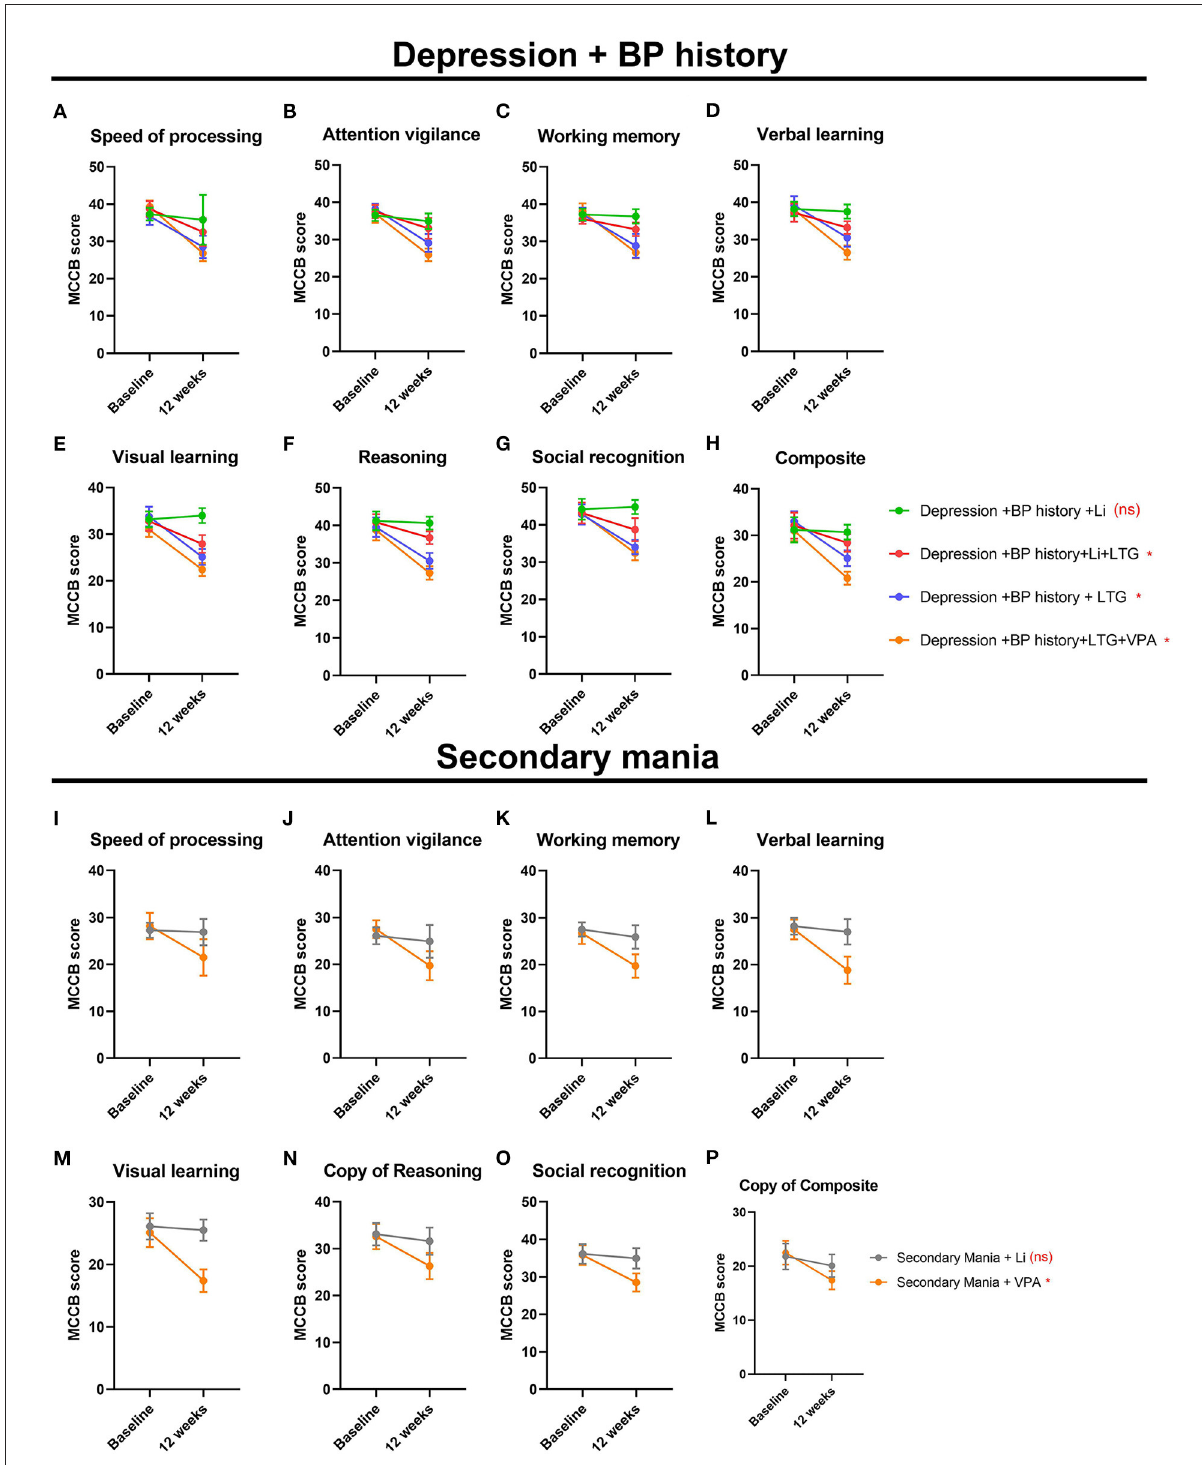
FIGURE6 Treatment effects on the cognitive performance of patients with BP. For patients experiencing their first depressive and manic episodes, respectively (A,I) processing speed, (B,J) attention vigilance, (C,K) working memory, (D,L) verbal learning, (E,M) visual learning, (F,N) reasoning, (G,O) social recognition, and (H,P) composite MCCB scores before and after 12 weeks of treatment. BP, bipolar disorder; MCCB, the MATRICS Consensus Cognitive